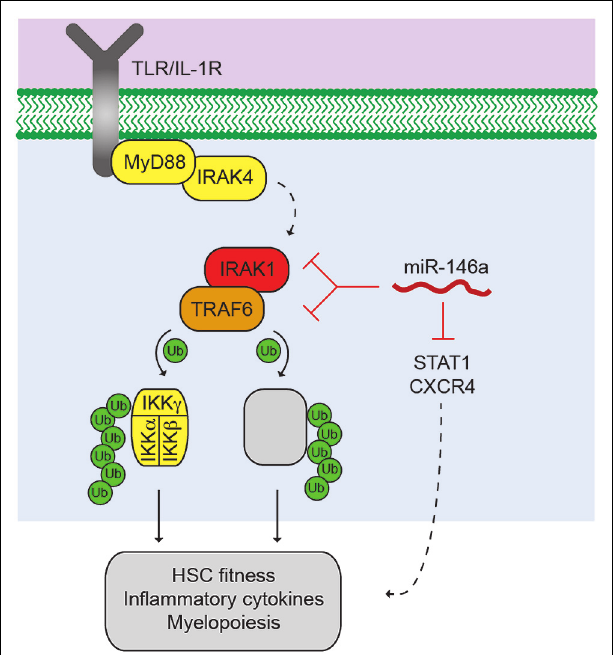
FIGURE 1 | Control of theTRAF6 signalosome by miR-146a. Activated Toll-like receptor (TLR) or lnterleukin-1 receptor (IL1R) results in the recruitment of MyD88 and IRAK4, which activates the serine/threonine kinase, IRAKI, through IRAK4-dependent phosphorylation (dashed line). IRAKI associates with an E3 ubiquitin ligase,TRAF6, which mediates the activation of the IKK complex through K63-linked polyubiquitin chains, resulting in NF- κ B transcription factor activation.TRAF6 also regulates other proteins (as indicated by grey box) that may also contribute to immune signaling and malignancies. miR-146a suppresses IRAKI andTRAF6 protein expression through direct binding at 3 (cid:3) UTR sites within IRAKI andTRAF6 mRNAs. Reduced expression and/or deletion of miR-146a results in derepression of IRAKI andTRAF6 protein, and increased downstream pathway activation resulting in reduced HSC fitness, increased inflammatory cytokine expression, and altered myeloid differentiation. miR-146a also represses STAT1 and CXCR4 in hematopoietic cells, which may also contribute to the HSC defects following deletion of